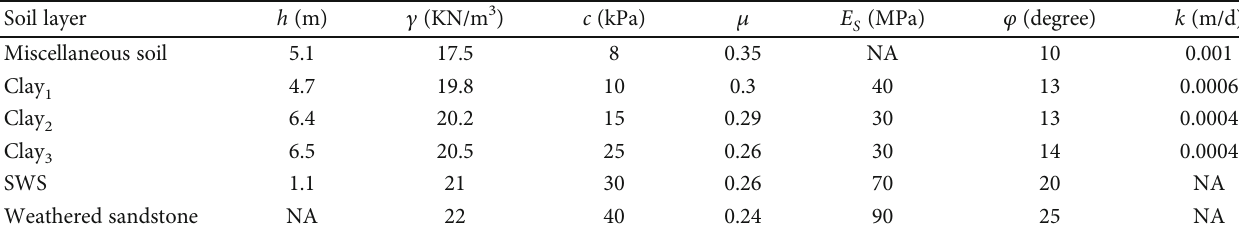
Table 4: Soil parameters for the HMLYRS Project.